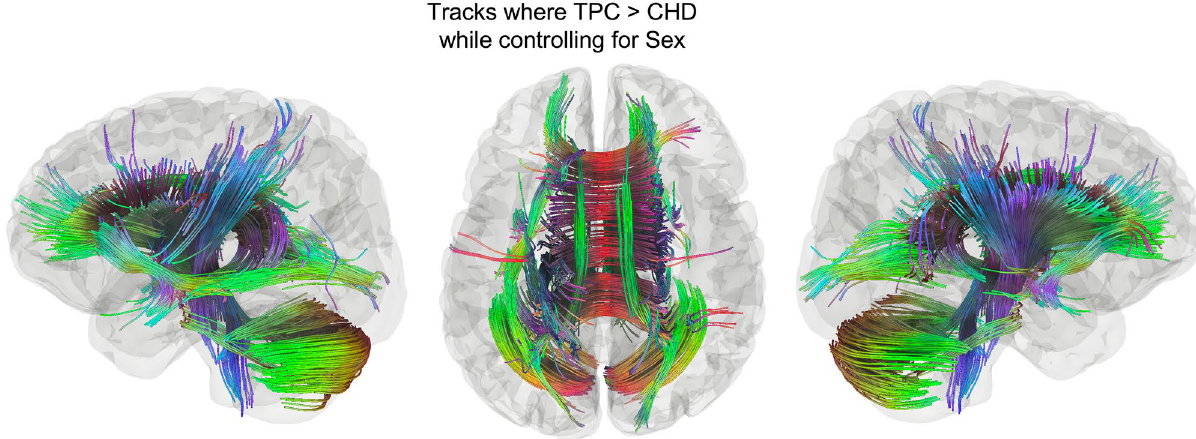
Figure 1. Tracks where TPC > CHD while controlling for sex. This contains much of the white matter, including bilateral inferior fronto-occipital fasciculi (IFOF), anterior and posterior aspects of the body of the corpus callosum (CC), bilateral cinguli, bilateral cerebellar tracts, and portions of bilateral corticospinal tracts (FDR = 0.0056).